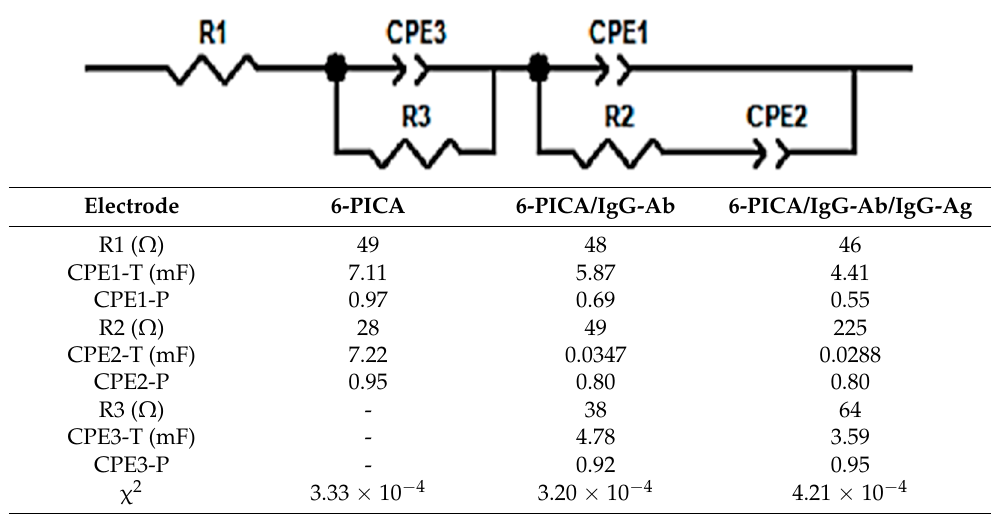
Table 1. Fitting results of EIS data. The quality of the fitting to the equivalent circuit was evaluated by an acceptable error value of χ 2 < 0.001. The changes in the electrochemical properties of the system were simulated using the modified Randles equivalent circuit model.